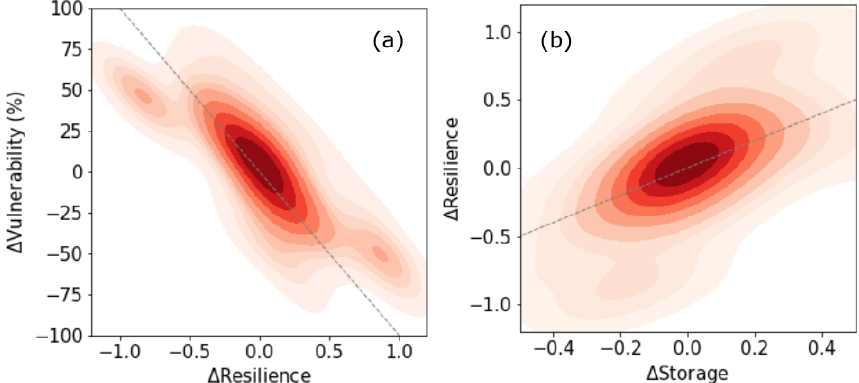
Figure 6. The relationship (dashed gray line: 1 : 1 line) between changes from the pre-2000 to the post-2000 period in (a) vulnerabil- ity ( (cid:49) Vulnerability) and resilience ( (cid:49) Resilience) and (b) mean storage ( (cid:49) Storage) and resilience ( (cid:49)